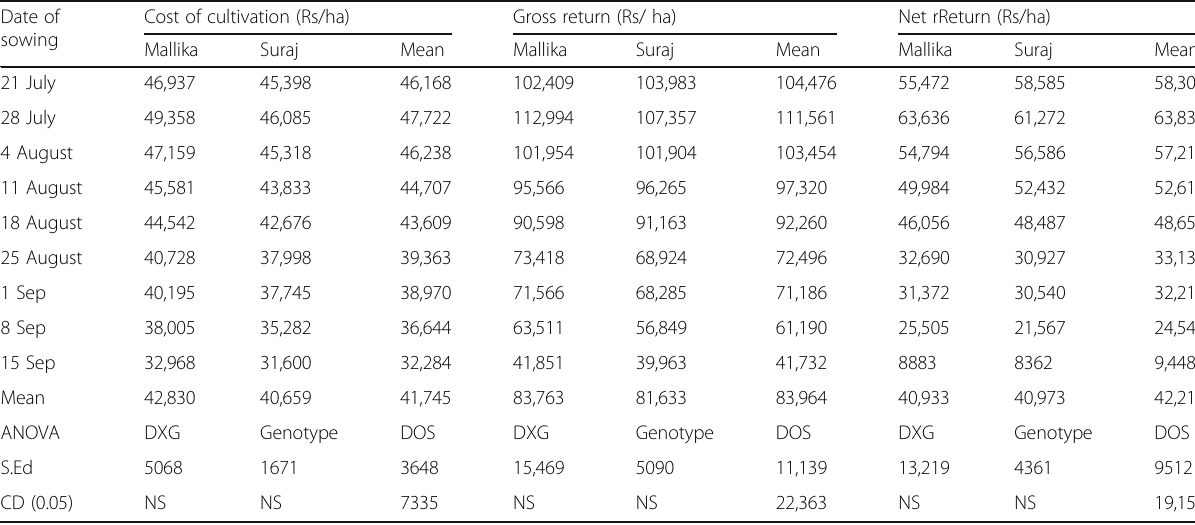
Table 5 Economics as influenced by genotypes and dates of